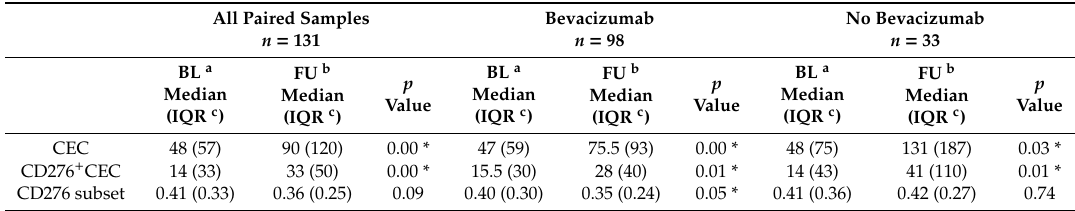
Table 1. Circulating endothelial cells (CEC) counts / 4